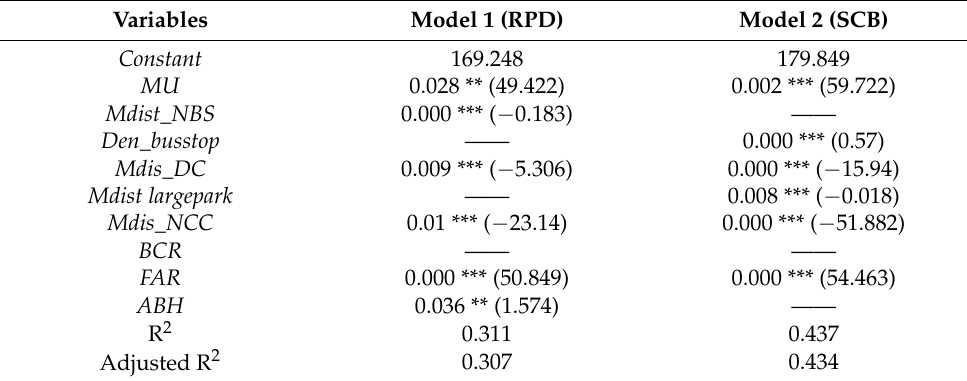
Table 4. Analysis results of multiple linear stepwise regression model.